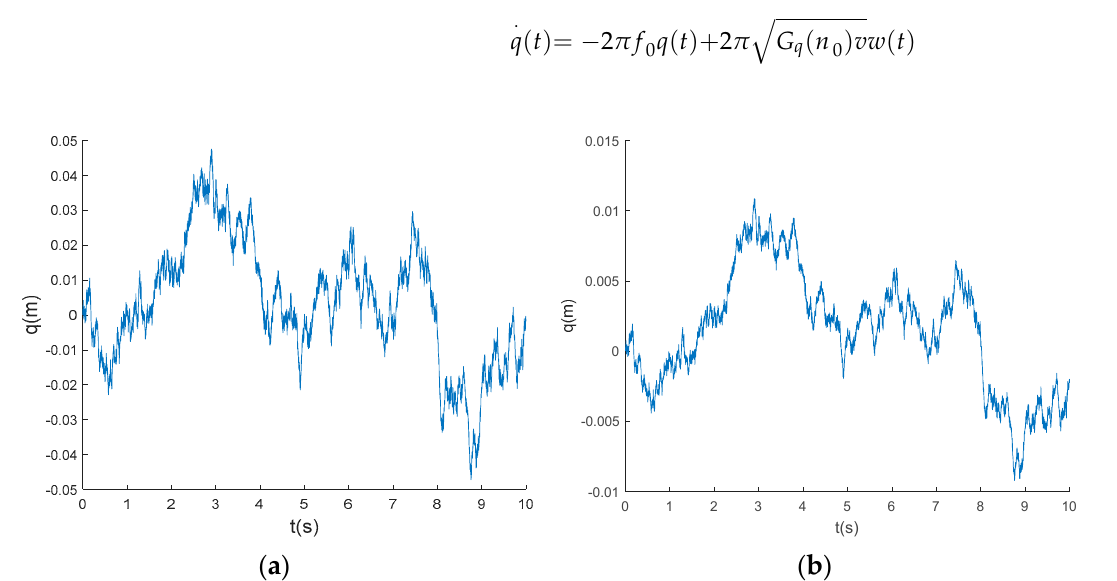
Figure 4. Road excitation: ( a ) C-class 20 m/s road excitation; ( b ) B-class 20 m/s road excitation.